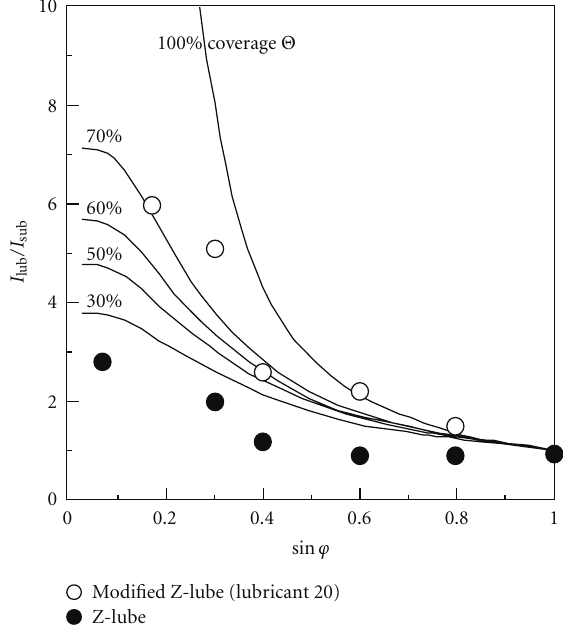
Figure 30: Coverage of the media surface with lubricant by ARXPS and the calculated curves (solid line) using island model shown for